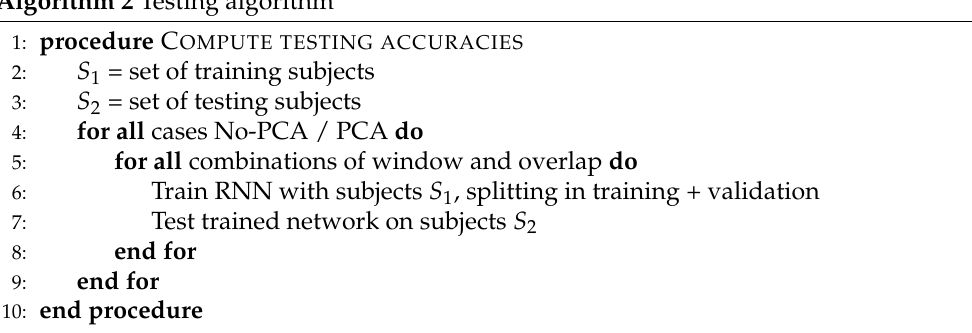
Algorithm 2 Testing algorithm